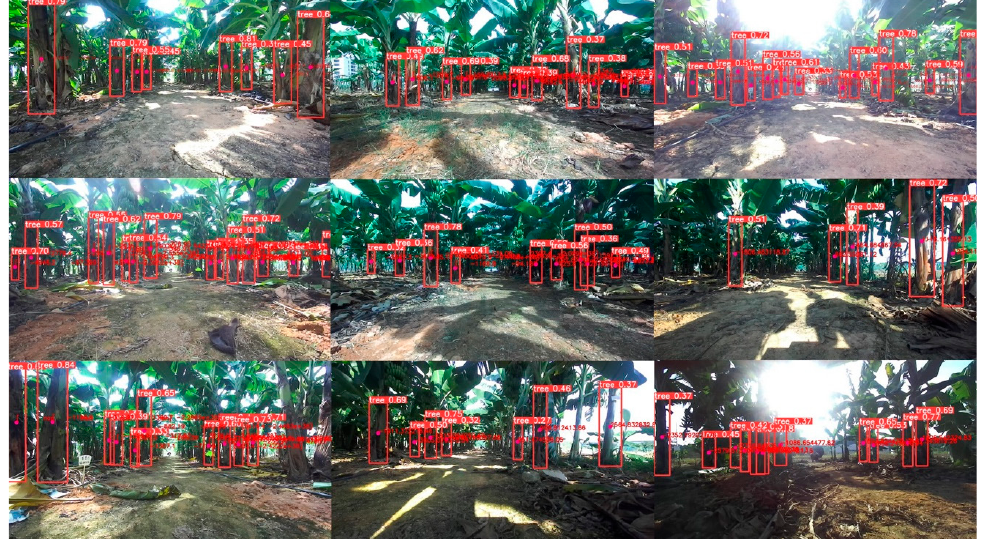
Figure 14. Examples of trunk detection in a banana orchard. Red boxes represent the detected trunks and the numbers above the boxes represent the detected con fi dence.